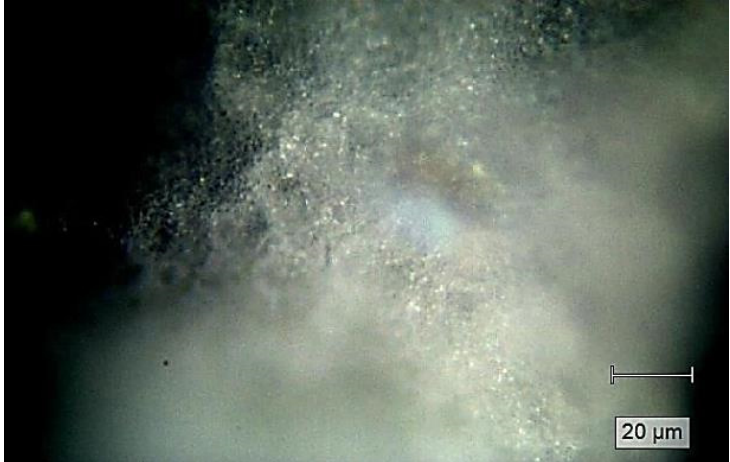
Figure 7. Raman imaging of PEBSA (75/25).